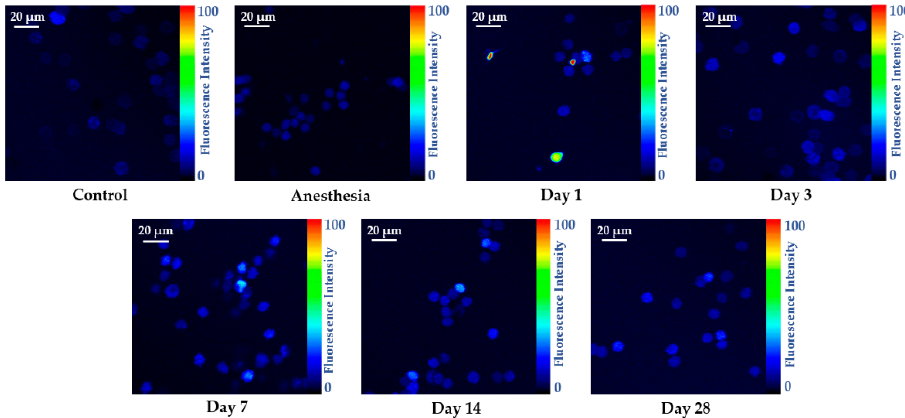
Figure 2. Representative two-photon fluorescence intensity images of RBCs from the control and irradiated animals measured on the 1st, 3rd, 7th, 14th, and 28th days after irradiation with the laser-driven UPEB.